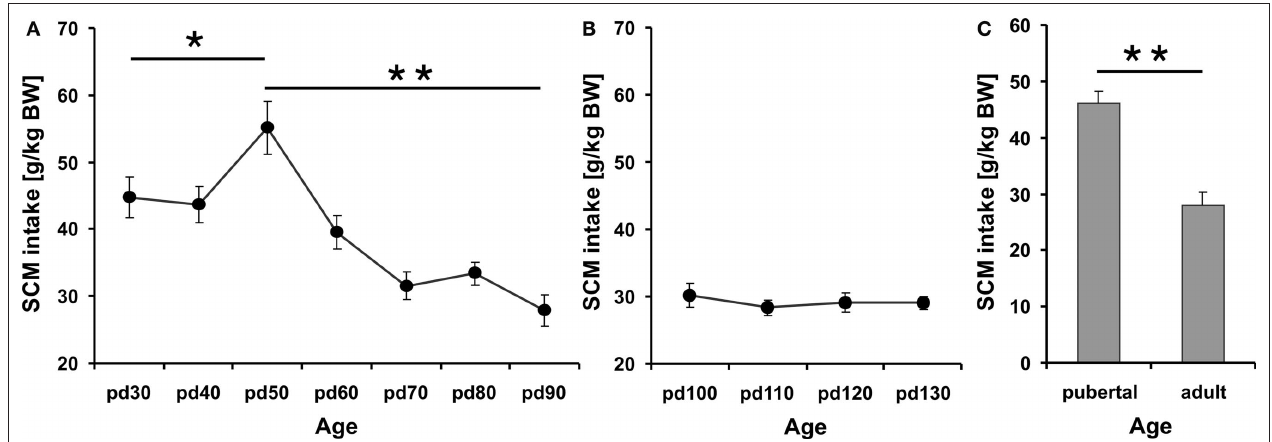
observed after repeated testing in adult rats (B) . In addition, the average SCM consumption of pubertal rats (PND 40–60) differed significantly from adult animals on pd 90 (C) . Asterisks (*) and (**) indicate significant differences at p -levels of p ≤ 0.05 and p ≤ 0.01, respectively. Data are expressed as mean ± SEM.